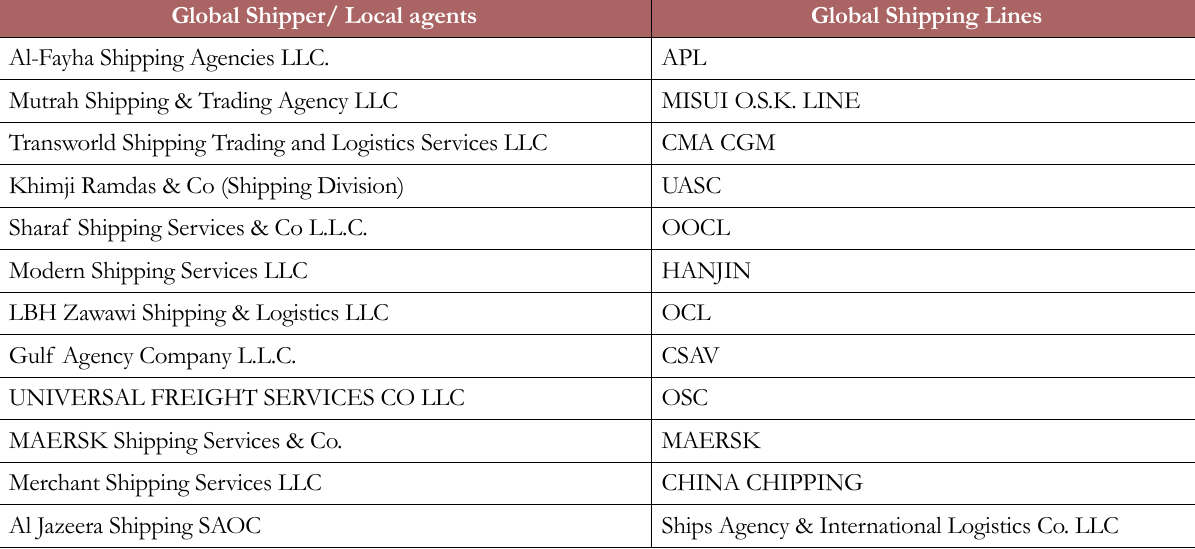
Table 2. Sample List of Shipping